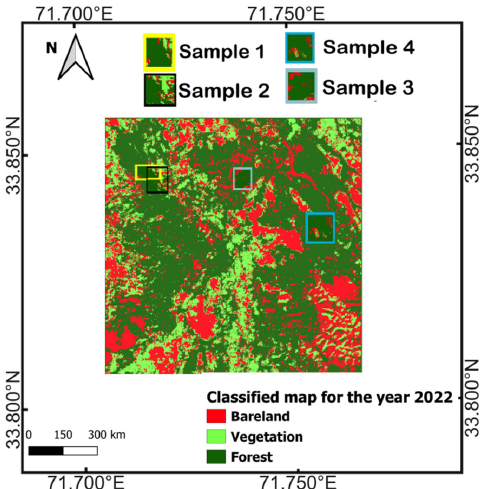
Figure 4. Sub area samples marked on classified image for UAV data collection.